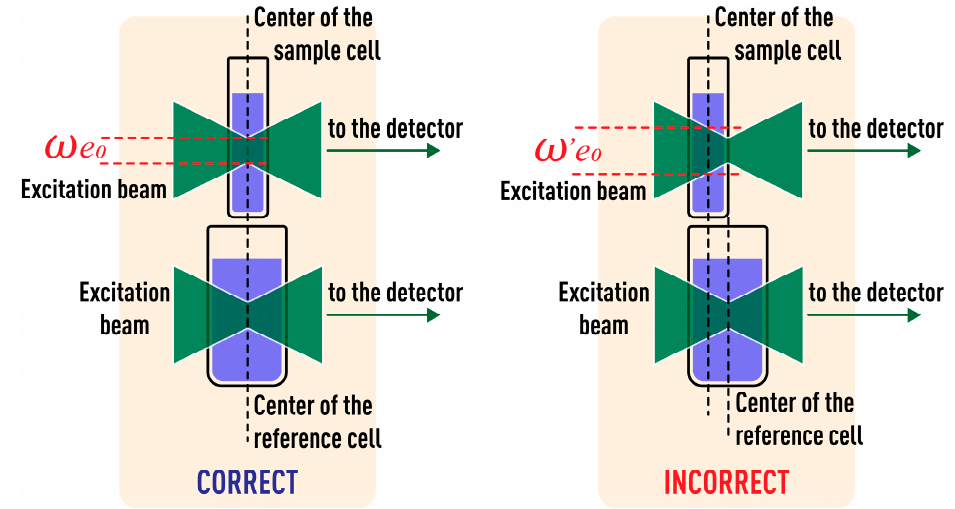
Figure 8. Location of sample and reference cells. See the text for details.